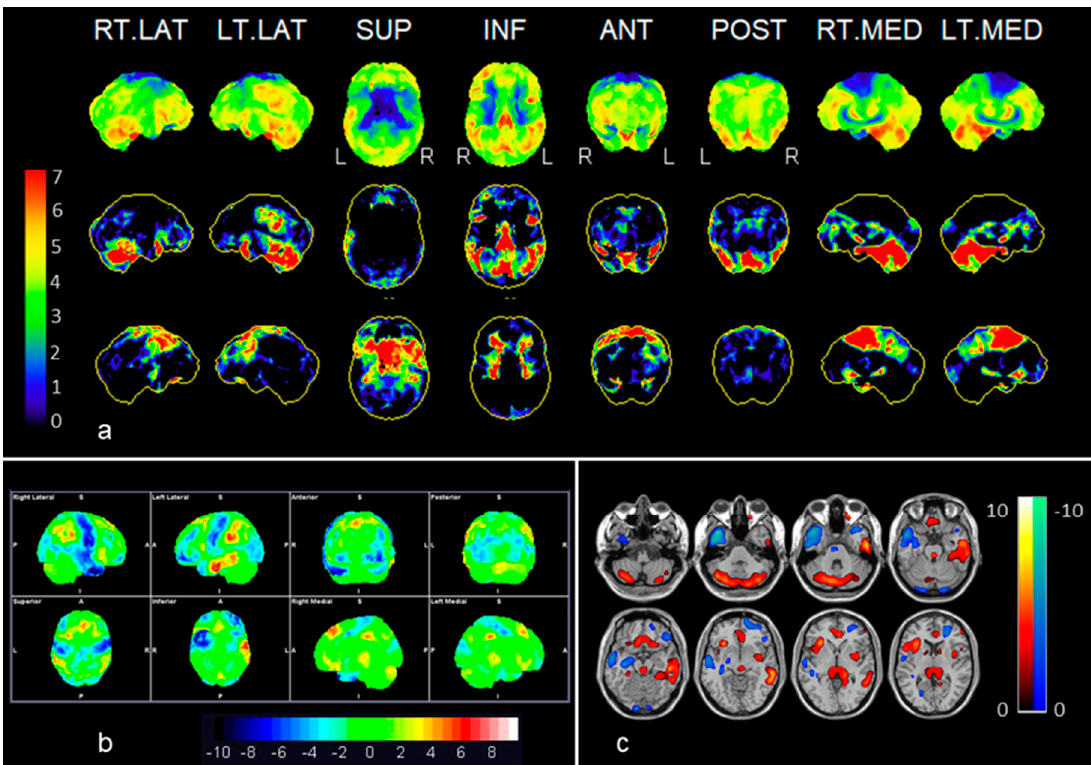
Figure 2. Example of anti-NMDAR (case 1): Neurostat ( a ) and syngo.via Database Comparison ( b ) were superior to SPM ( c ) exhibiting bilateral frontal, right temporal, occipital and bilateral motor cortex hypometabolism, as well as more hypermetabolic areas including temporo-parietal, posterior cingulate and cerebellum. Color bars represent significant increases or decreases in brain metabolism compared to a normal database stratified by age. In the displayed Neurostat and SPM results, all the colored voxels represent statistical significance when compared to normal controls (Neurostat: increases and decreases in red to green; SPM: increases in, red to yellow, decreases in blue), whereas in the syngo.via Database Comparison, the significant voxels can be identified according to the SD color bar, 2 SD being the threshold of statistical significance (i.e., areas with green voxels are not significant). See also Table 2.